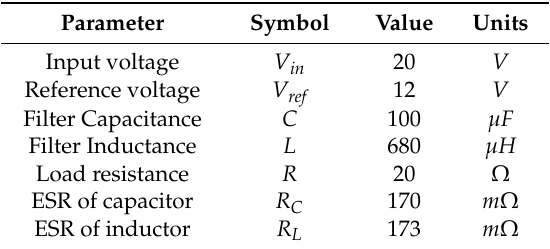
Table 1. Circuit parameters of the buck